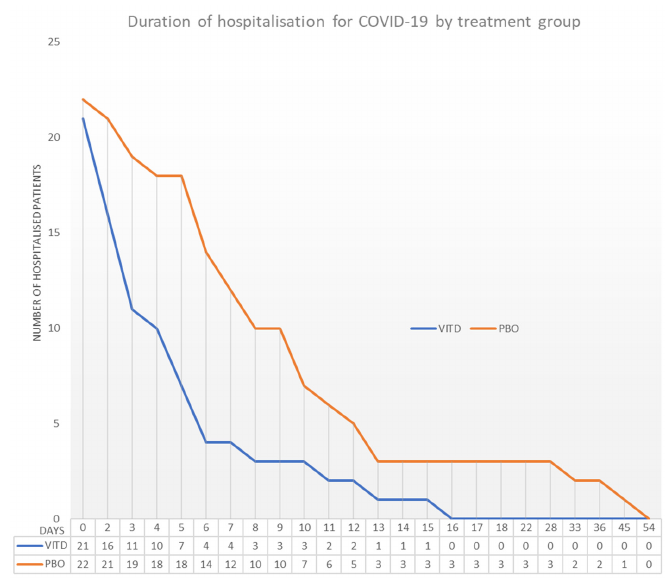
Figure 2. Number of hospitalized patients by treatment group.